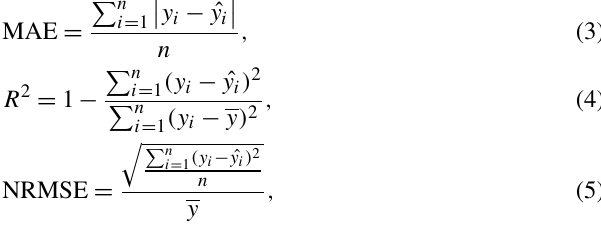
are replicated by the estimation method, based on the pro- portion of total variation of outcomes explained by the es- timation method. NRMSE represents the standard deviation of the estimated errors with respect to its mean. NRMSE is used rather than the commonly used RMSE because the num- ber concentrations of the different size range are of different comes different if RMSE is not normalised with its